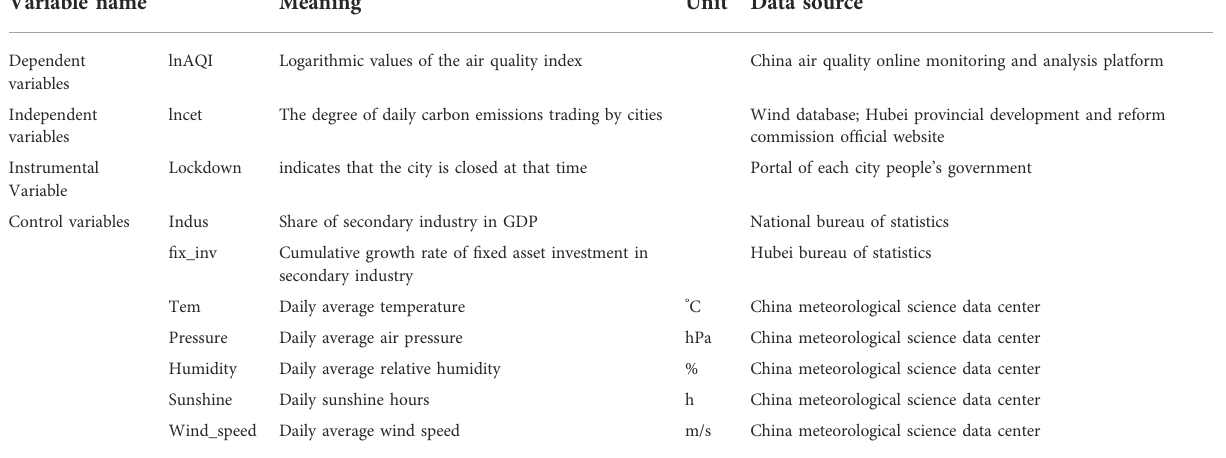
TABLE 2 Setting of each variable and data